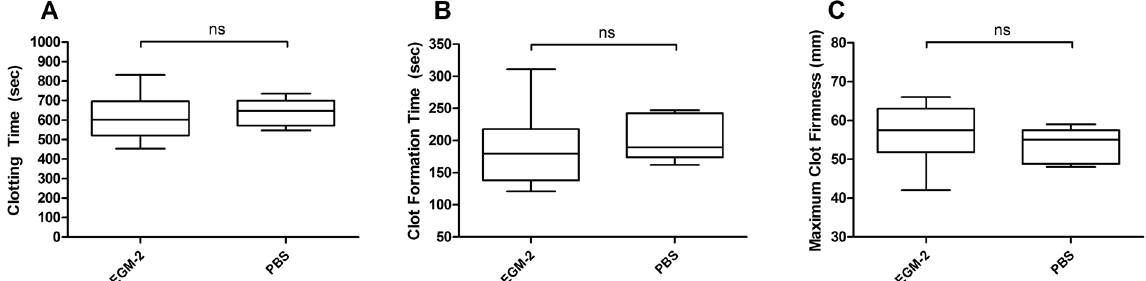
Figure 3. Effect of cell culture medium EGM-2 and sample buffer PBS on ROTEM parameters. For control and exclusion of effects of medium/buffer 50 µ l of EGM-2 or PBS were added to 300 µ l fresh whole blood and subjected to ROTEM analysis. Box-and-whisker plots (min, max, 25th–75th percentile, median); ns = not significant. n = 4–6 measurements.